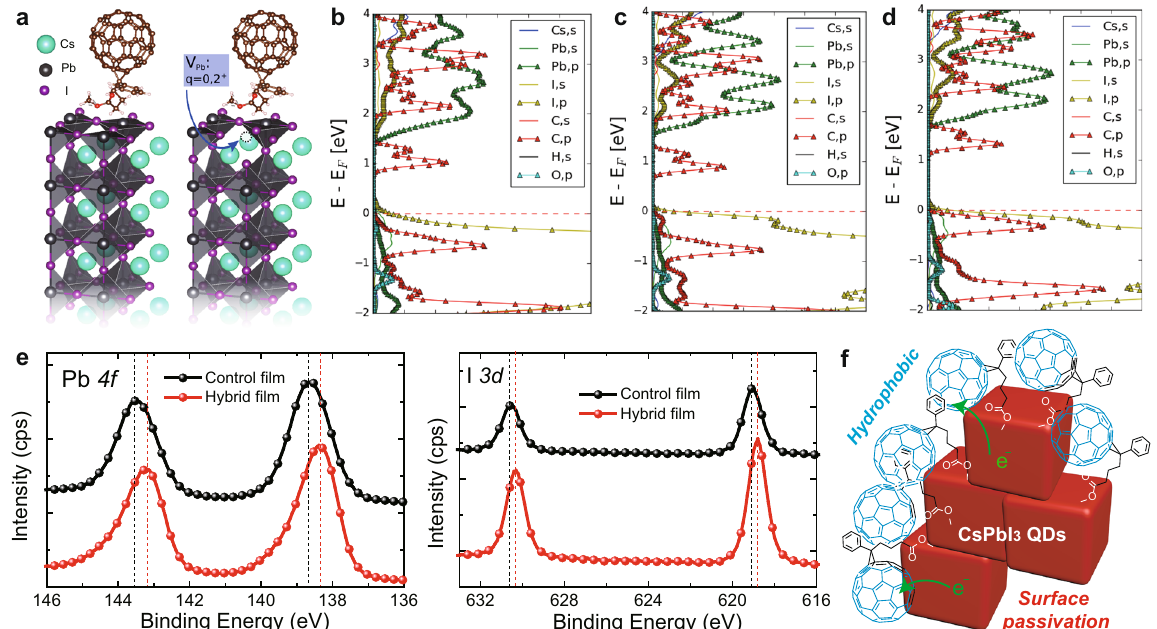
Fig. 4 Molecular interaction between QD and PCBM. a Schematic diagrams of the simulated unit cell, showing the perovskite slab system with and without a charged Pb-vacancy defect. b – d The electronic pDOS for three cases: without Pb-vacancy, with a neutral, and with a Pb-vacancy carrying a formal 2 + charge. e XPS signals of Pb 4 f and I 3 d in the control and the hybrid fi lms. f Schematic diagram of the hydrophobic PCBM passivating surface of CsPbI 3